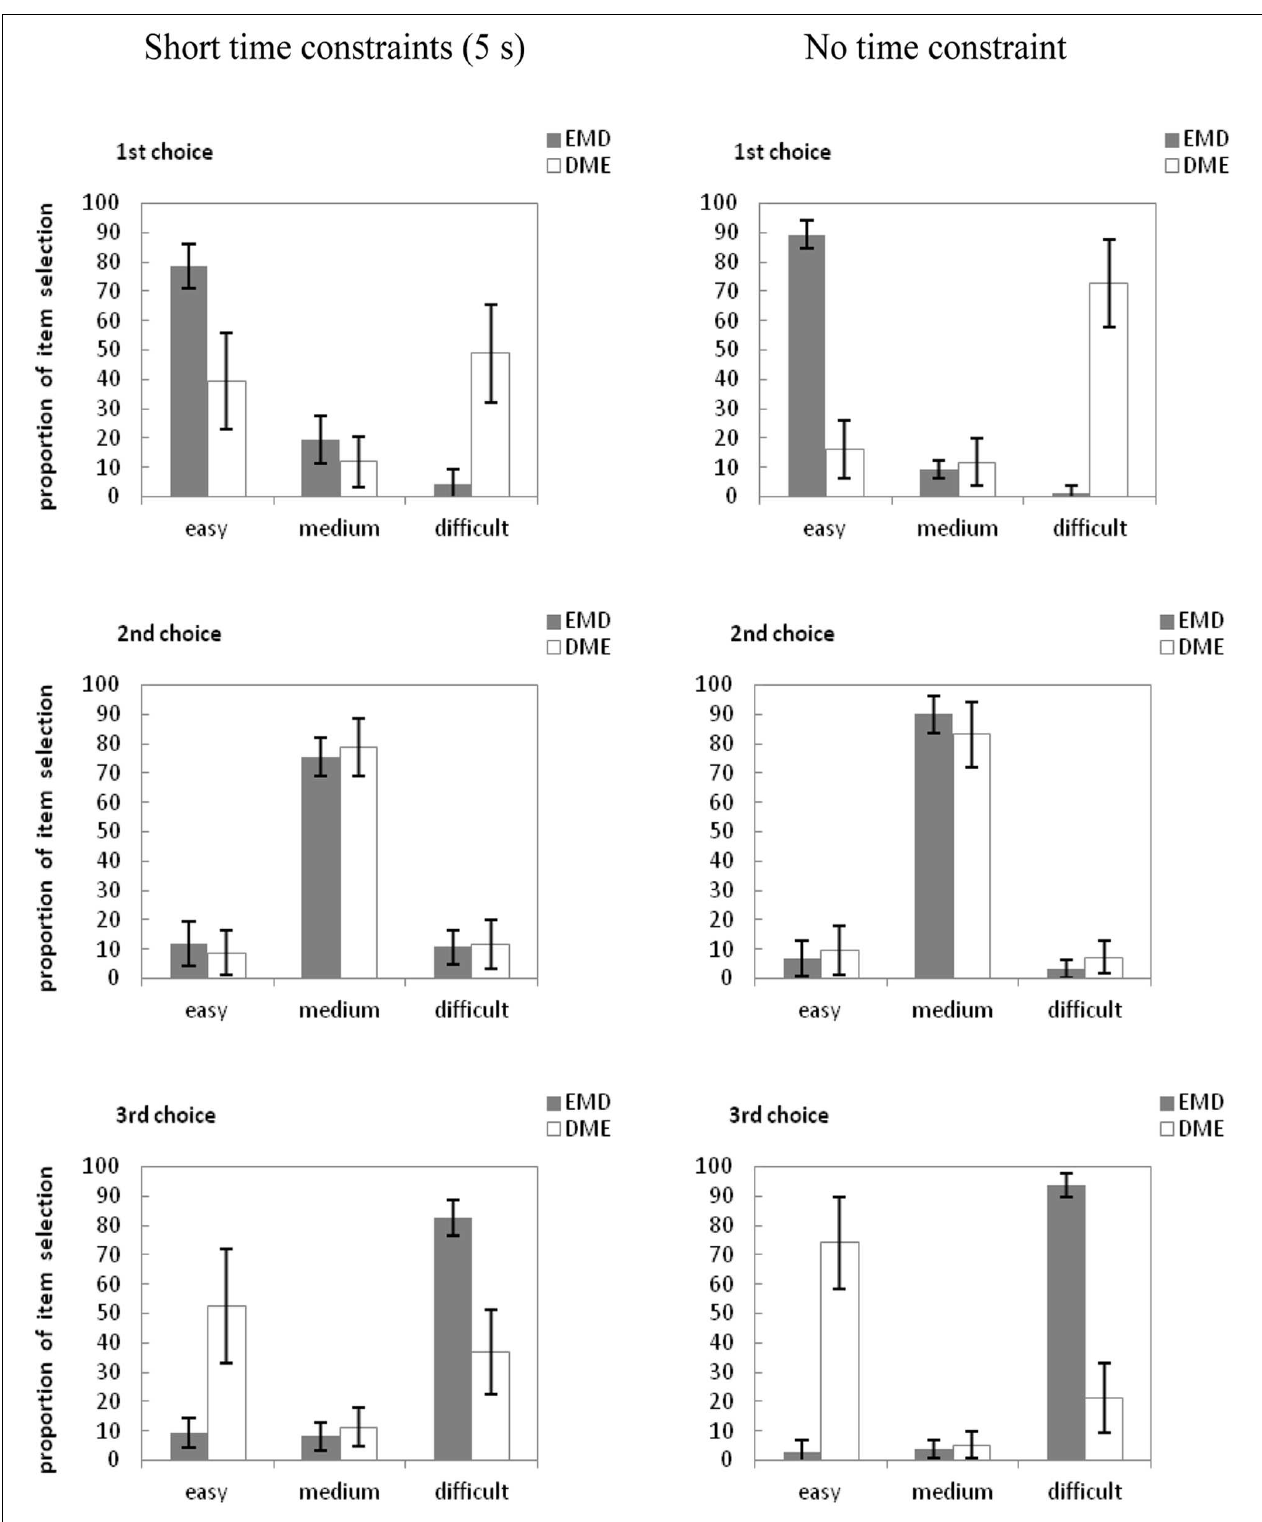
FIGURE 4 | Mean proportion of items selected for the first, second, and third choice across the word pair arrays in Experiment 3b. E, easy word pair; M, moderately difficult word pair; D, difficult word pair. Error bars are standard errors of each mean.